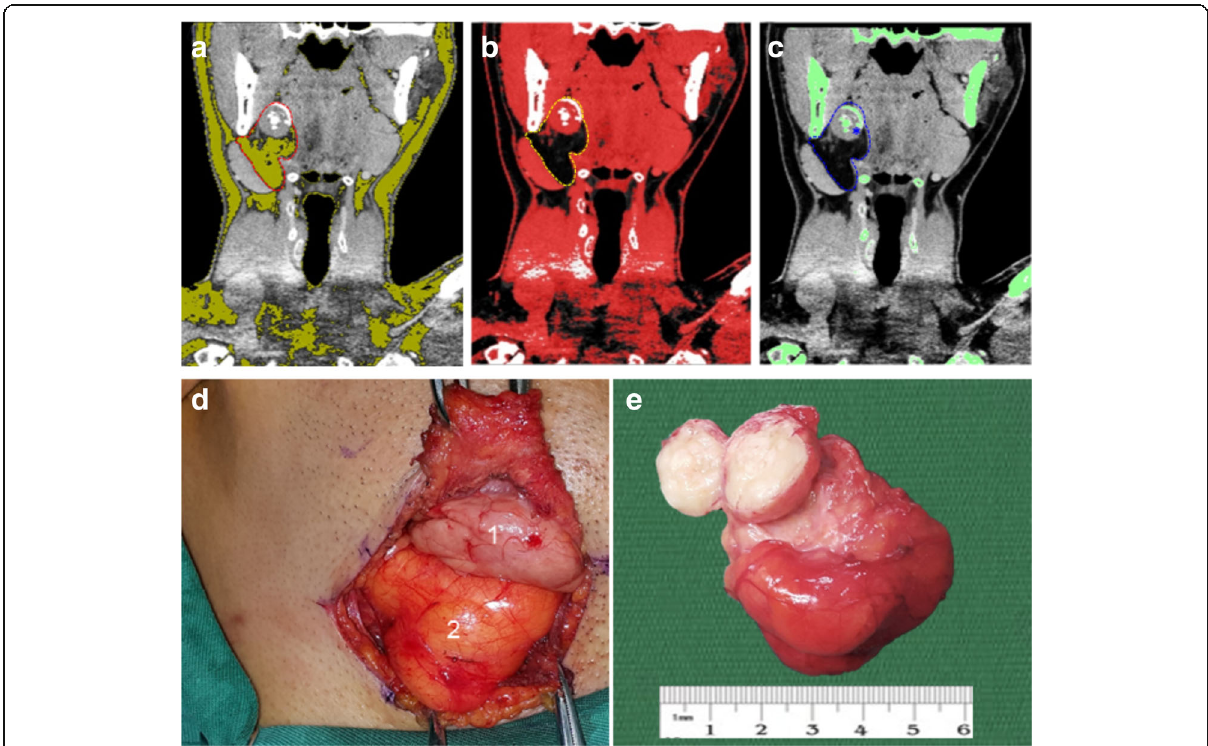
Fig. 2 Additional tissue masks were made using the image viewer revealing that the tumor waspossibly composed of fat (yellow) ( a ), connective tissues (red) ( b ), and osteoid materials (green) ( c ) as outlined by the dotted line. Intraoperative photograph shows submandibular gland (1), lesion (2) ( d ). Gross specimen of the lesion after the surgery ( e